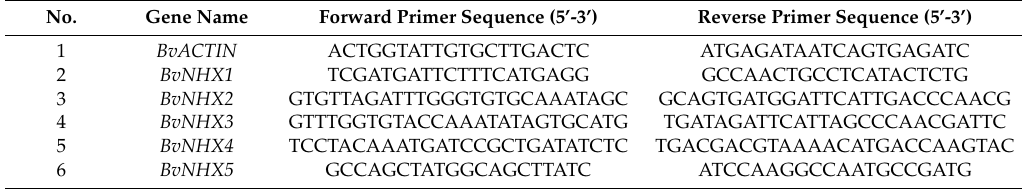
Table 1. The sequences of primers used for